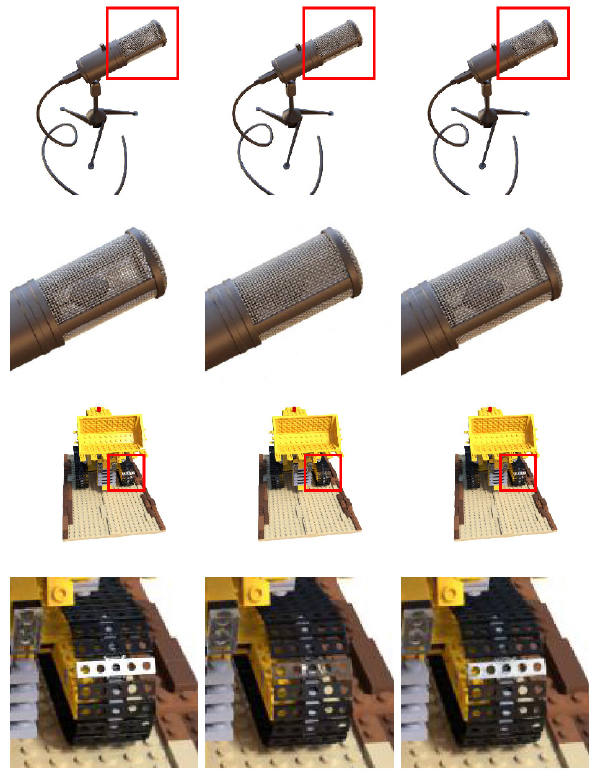
Fig. 2 Renderings of Mic and Lego scenes. Left to right: ground- truth, original implementation, and JNeRF implementation.